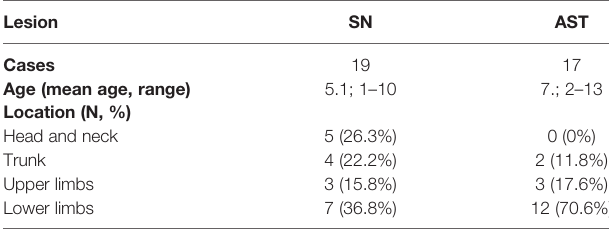
TABLE 2 | Clinical features of Spitz nevus and atypical Spitz tumor lesions subjected to PRAME immunohistochemistry testing. Lesion SN